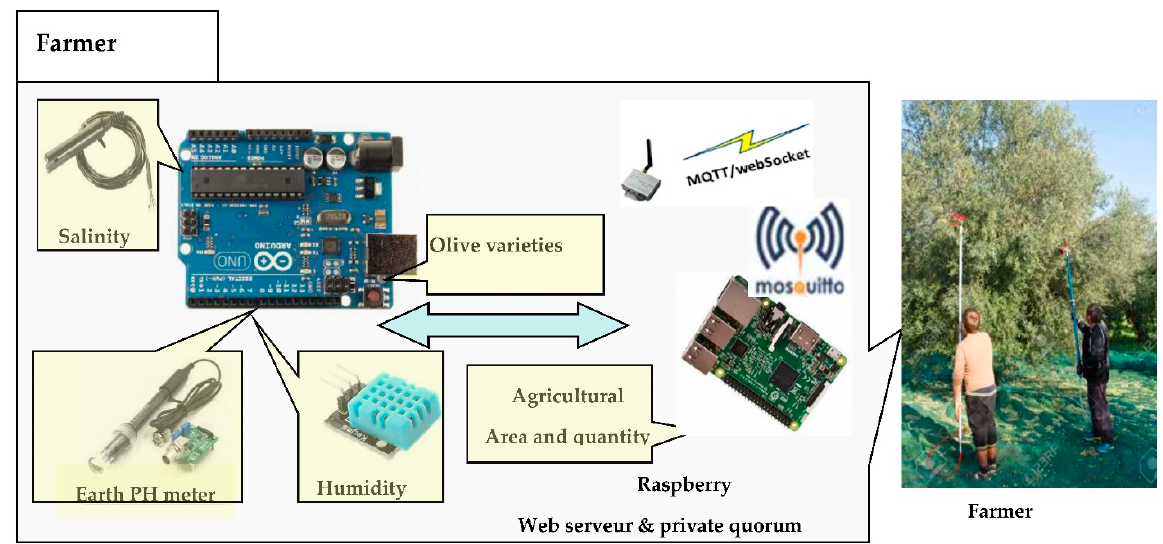
Figure 6. Farmer platform.